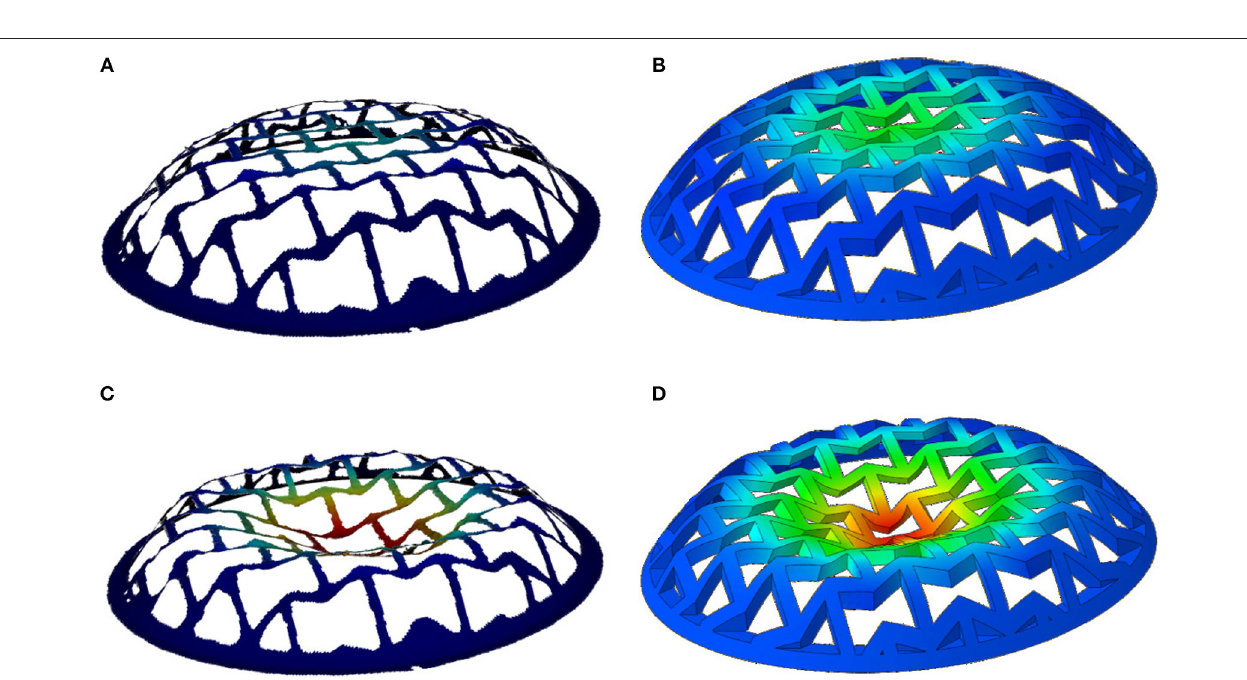
FIGURE 8 | DIC vs. FE vertical displacements (DIC on the left and FE on the right), showing (A,B) at the onset of buckling, and (C,D) when the dome center touches the bottom